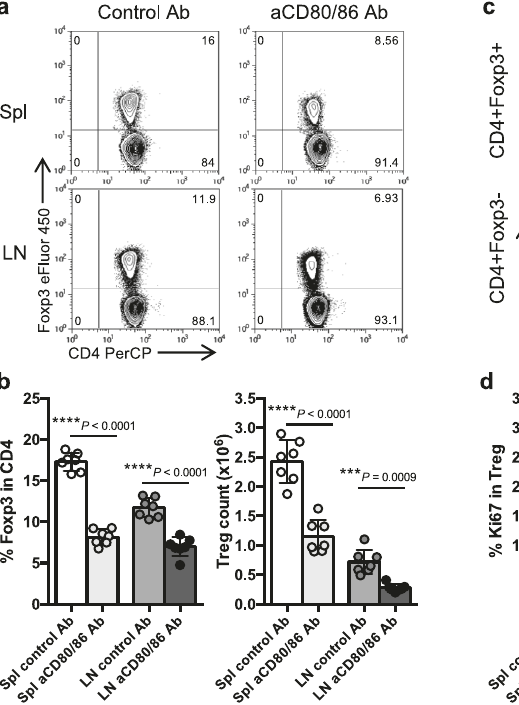
fromspleen c andpooleddata d illustrateKi67expressiononTreg(CD4+Foxp3+) or Tconv (CD4+Foxp3-) ( n =7 per group). Data are collated from 3 independent experiments. Graphs b and d show mean±s.d.; each dot represents one mouse. ** P <0.01,*** P <0.001,**** P <0.0001(two-tailed t test).Sourcedataareprovidedas a Source Data fi